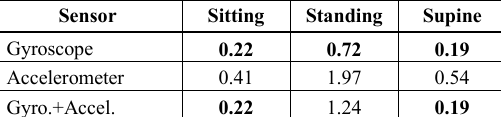
TABLE II. B REATHING R ATE E STIMATION ( N : 648)